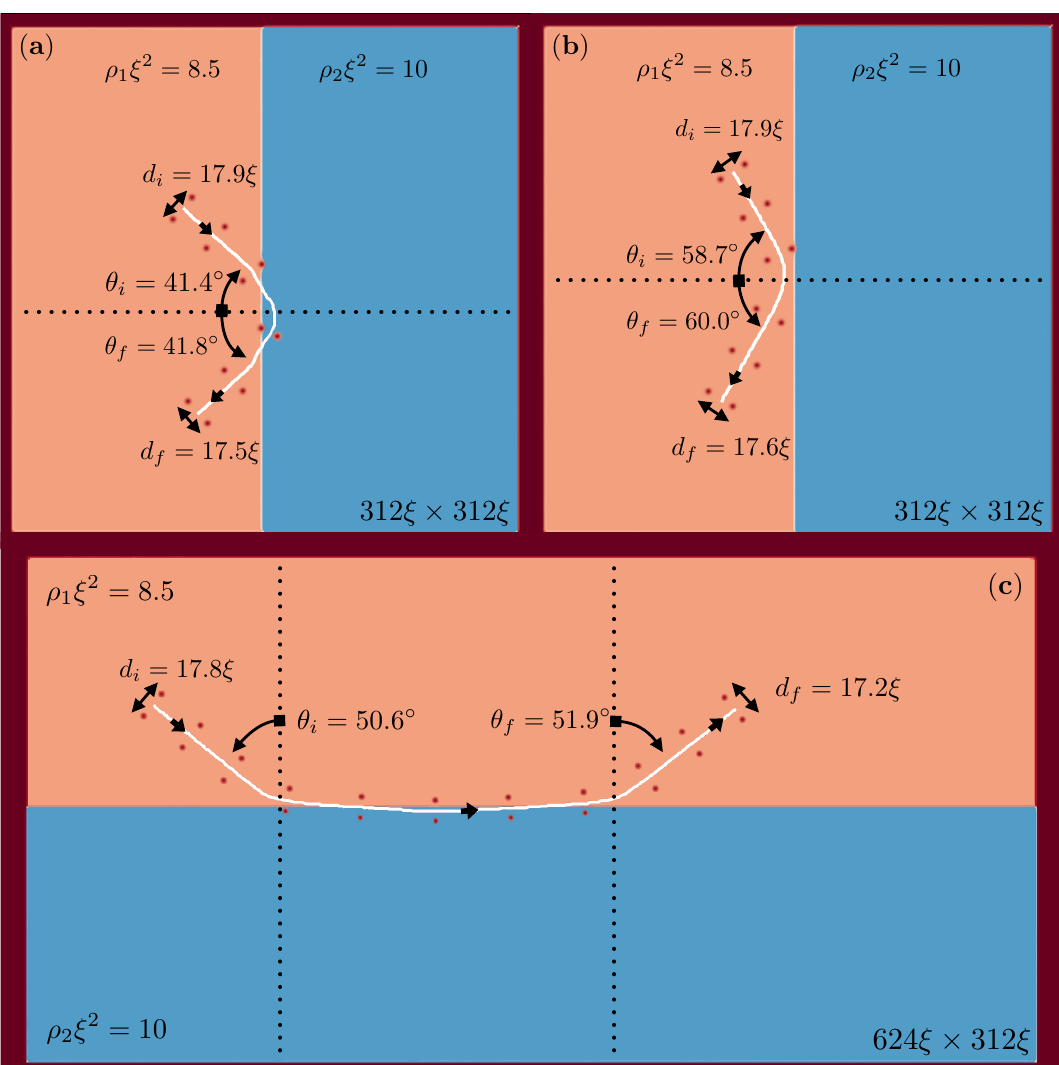
< ρ Figure 2: Vortex dipole motion across a density interface with ρ . Each subfig- 1 2 ure shows the same vortex dipole, superimposed at different times during its motion. The line between the vortices traces out the centre of the dipole; for each case, the (cid:38) θ (cid:39) 39.7 ◦ . ( a ) For θ critical angle is θ , the dipole undergoes total internal reflec- c i c (cid:29) θ tion. ( b ) For θ , the dipole again undergoes total internal reflection. ( c ) For an i c intermediate range of angles above the critical angle, the dipole straddles the inter- face between the two regions of superfluid density before undergoing total internal